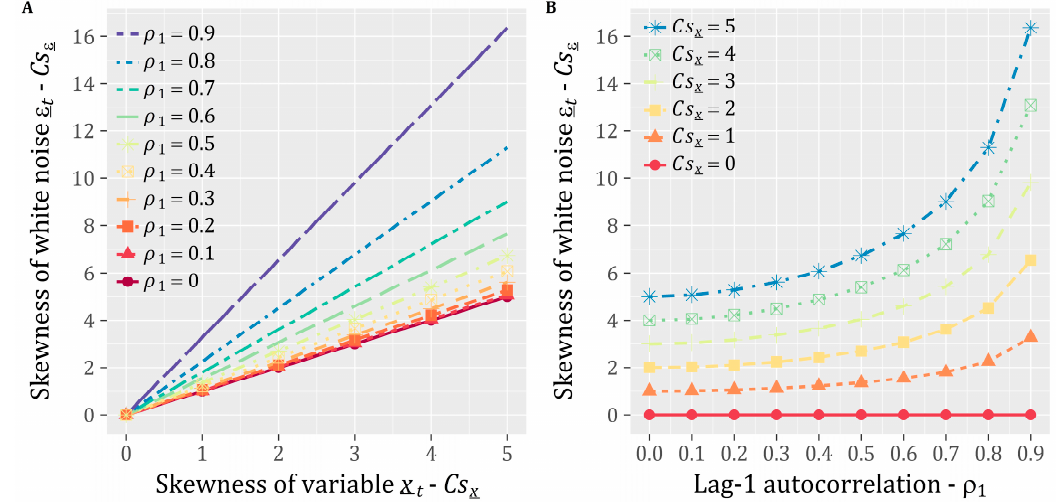
Figure 2. Relationship between ( A ) the target skewness coefficient of process x t and the required skewness for white noise term ε t for a given lag-1 autocorrelation coefficient ρ 1 ; and ( B ) the lag-1 autocorrelation coefficient ρ 1 and the required skewness coefficient of white noise term ε t to attain the target skewness coefficient of process x t .